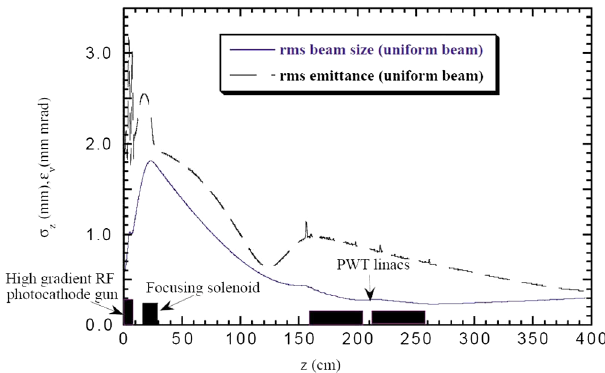
FIG. 11. Optimized rf photoinjector design using the Ferrario working point, from